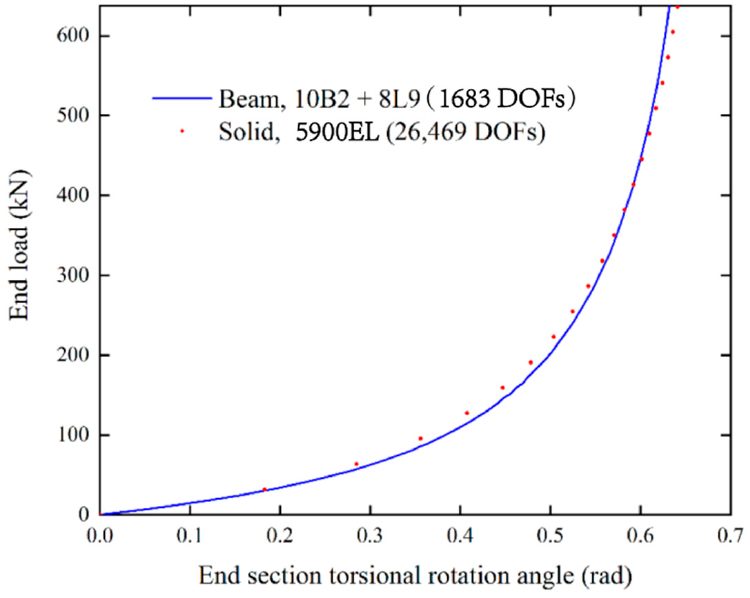
Figure 16. End-section torsional rotation of a pre-twisted cantilever with airfoil profile cross sec- tion.